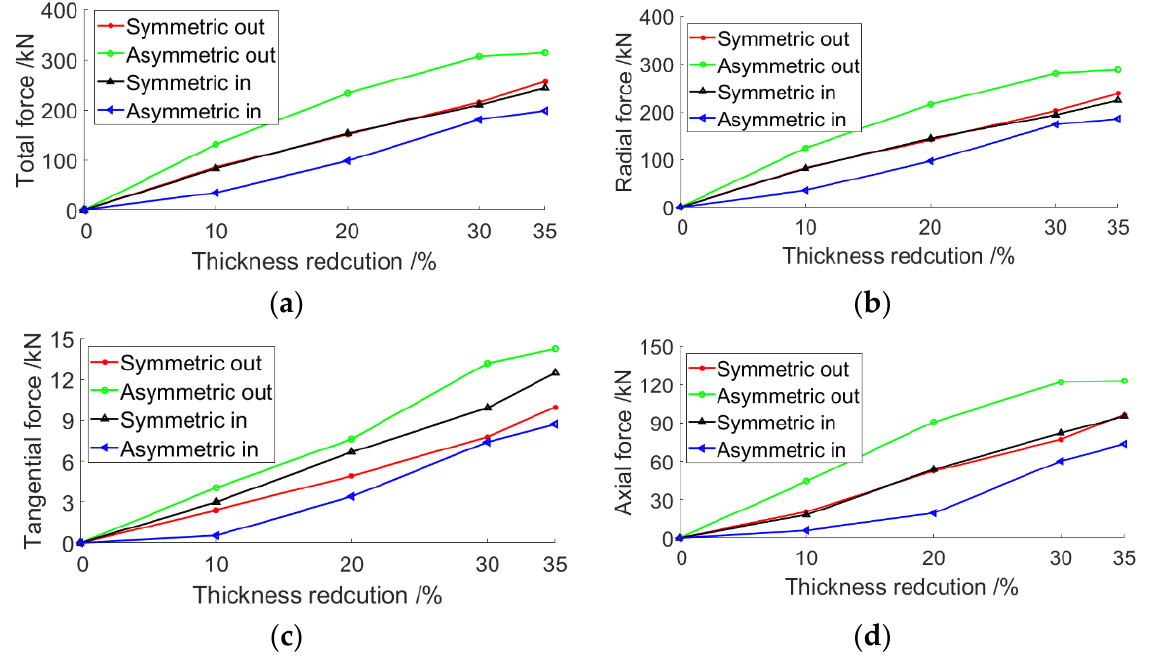
Figure 18. The thickness reduction of the tube blank influence on the flow-forming force: ( a ) Total force; ( b ) Radial force; ( c ) Tangential force; ( d ) Axial force. (out: outer roller force; in: inner roller force).